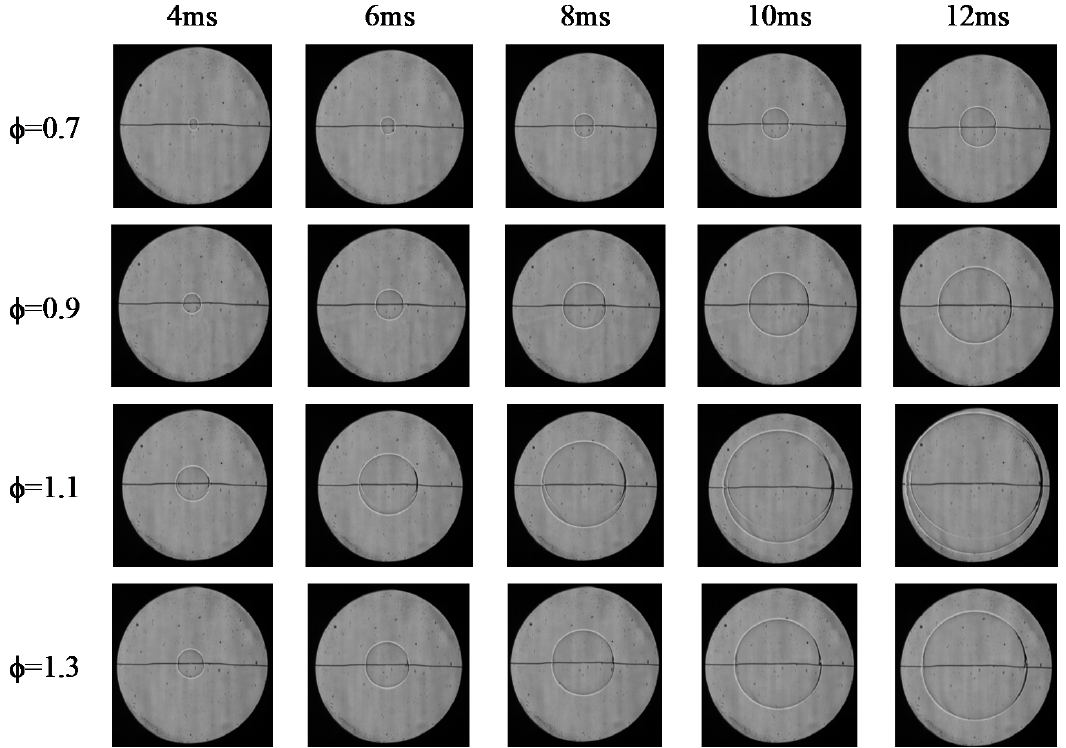
Figure 2. Schlieren flame images of hydrogen–ethanol fuel. Hydrogen composition is 30%, T0 = 400 K, and P0 = 0.1